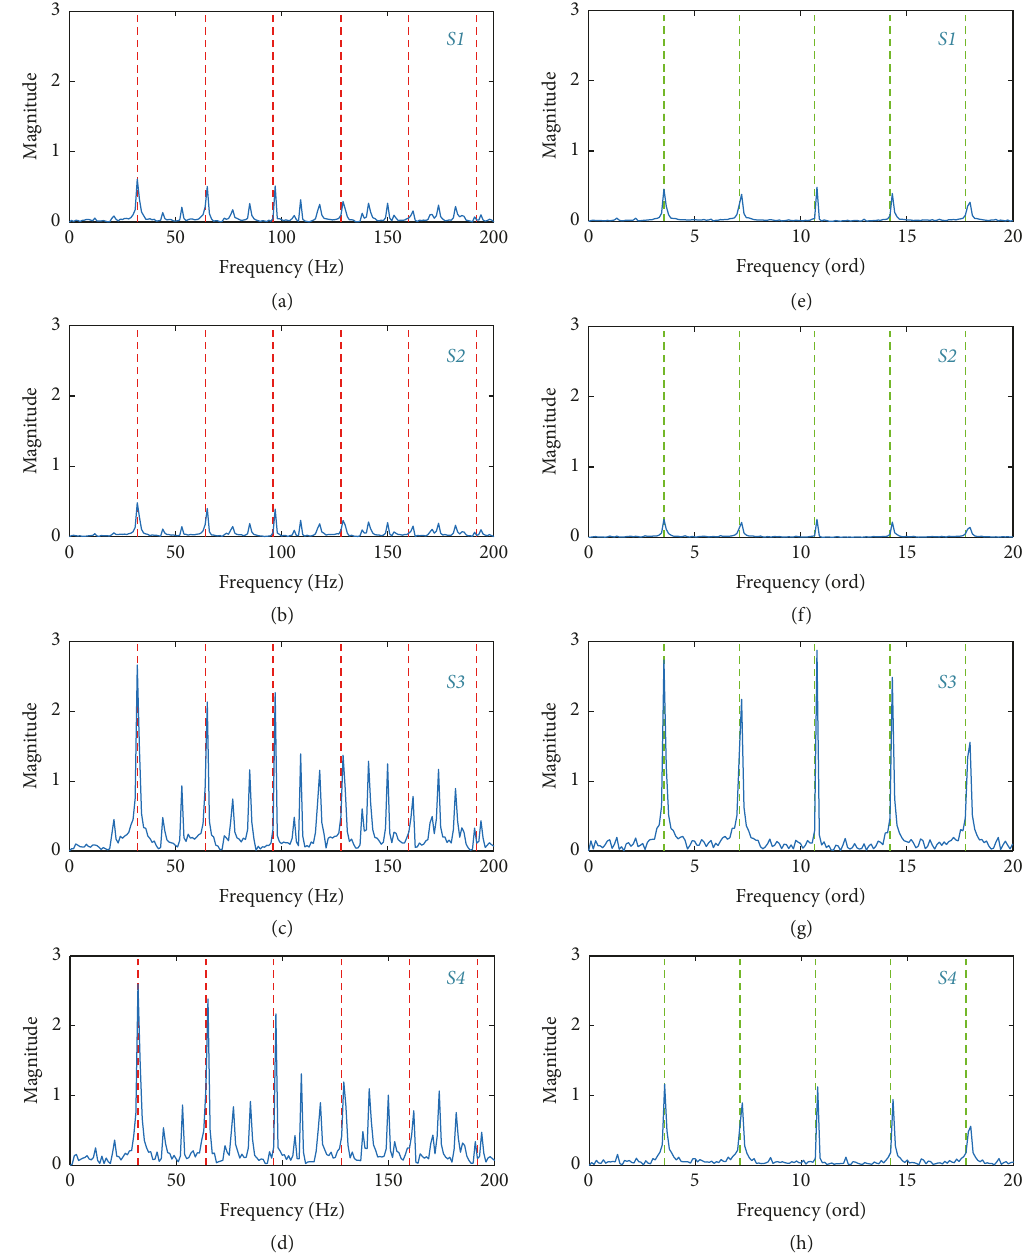
Figure 14: Envelope spectrums (a–d) and envelope order spectrums (e–h) for the time domain signals in Figure 13, respectively, from (a) to